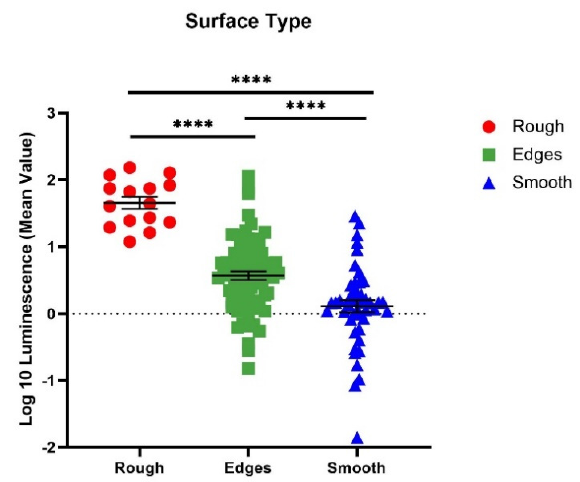
Figure 6. Comparison of each different surface type amongst all implants. Implant locations of similar surface types were combined to observe the average luminescence of each surface type. n ≥ 3; geometric mean ± SE (**** p < 0.0001).